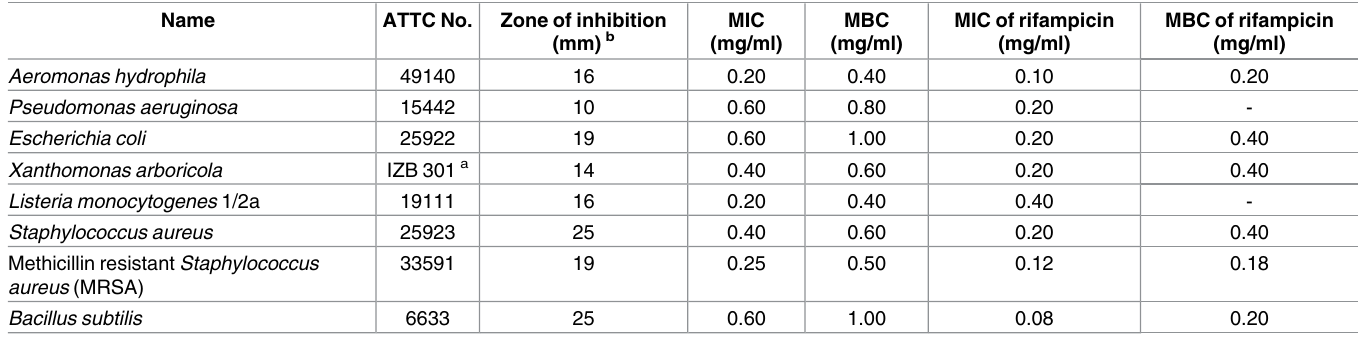
Table 2. Antibacterial activity of defensive secretextract from Pachyiulus hungaricus (Karcsh, 1881).